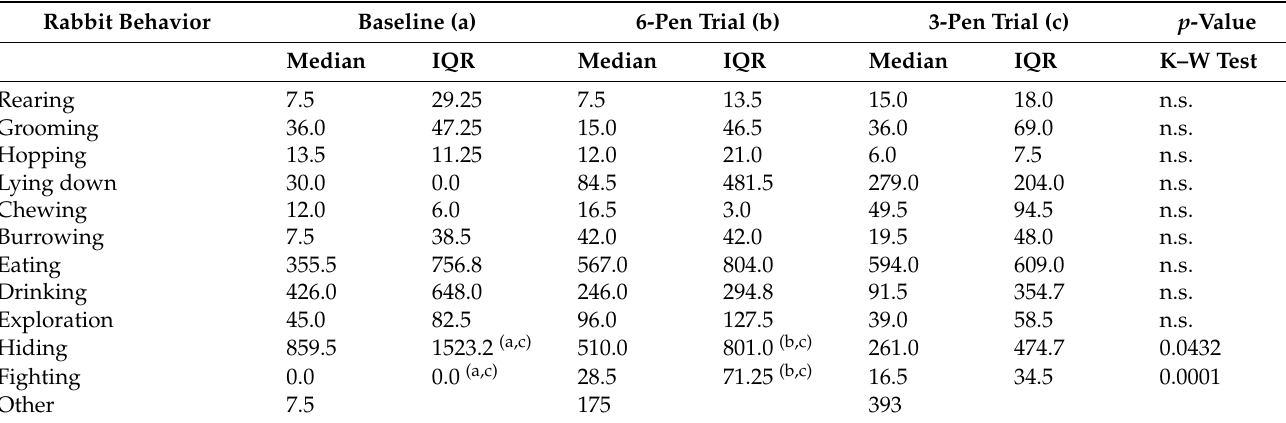
Table 2. Median time spent (in seconds) performing different behavioral